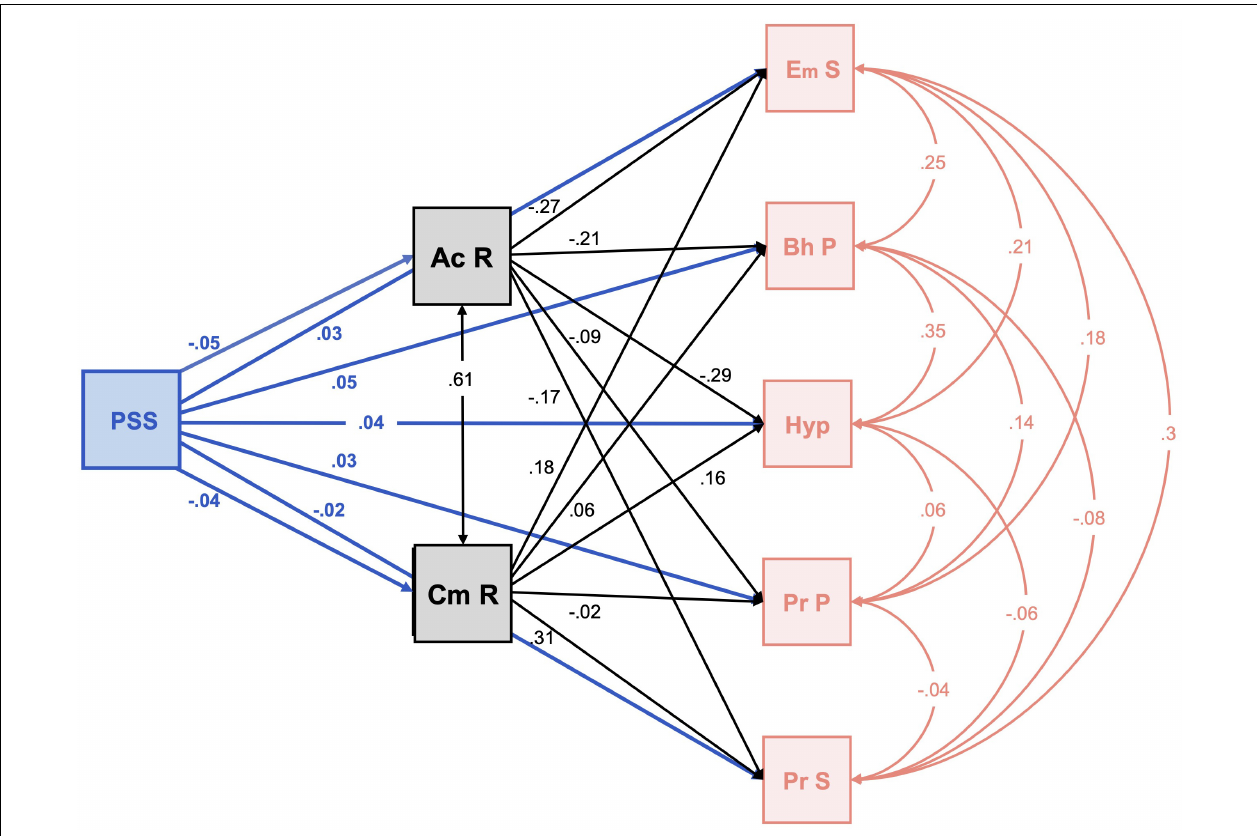
FIGURE 2 | Mediation analysis between parental stress and difficulties in children with resilience as a mediating factor. PPS: parenting stress; Ac R: self-acceptance resilience; Cm P: resilience competences; Em S: emotional symptoms; Bh P: Behavioral problems; Hyp: hyperactivity; Pr P: peer problems; Pr S: prosocial. All lines represents direct